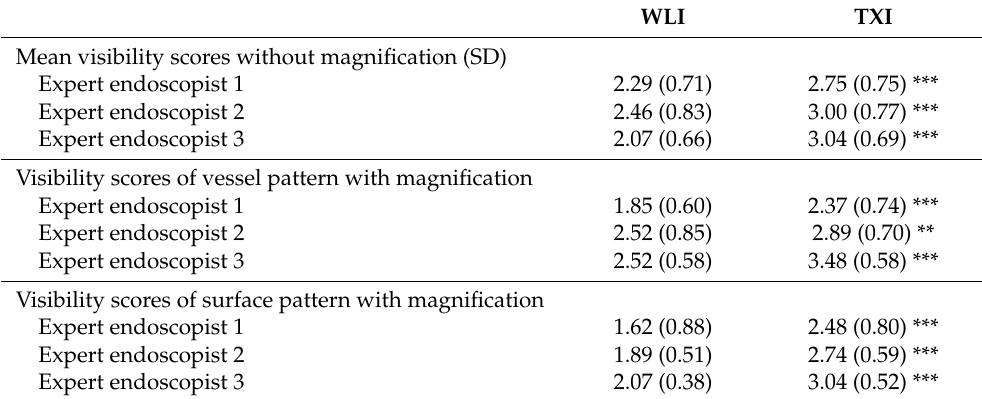
Table 4. Visibility scores for WLI and TXI assigned by each expert endoscopist.